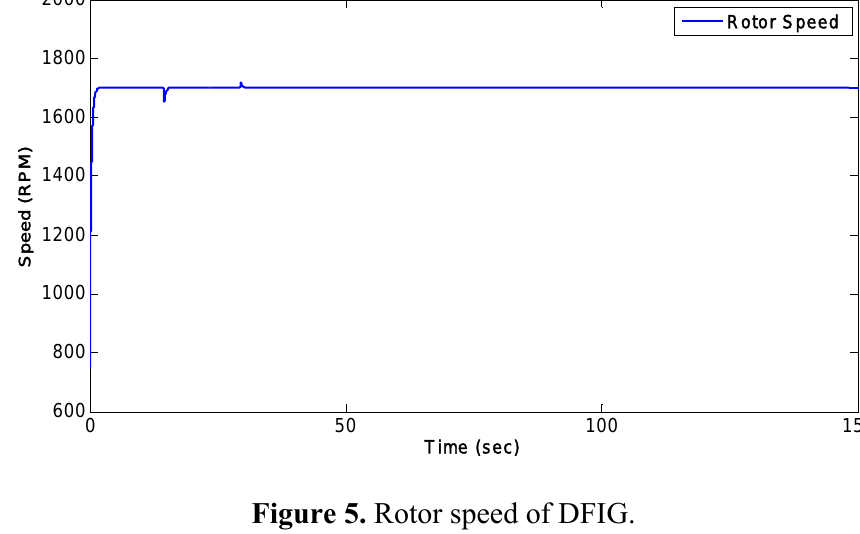
Figure 5. Rotor speed of DFIG.